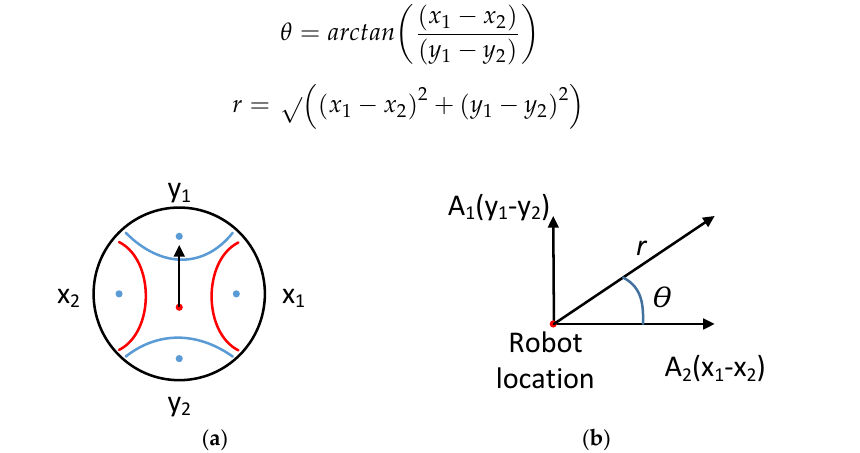
Figure 3. ( a ) Top view illustration of the physical arrangement of two pairs of antennae with their reflectors aligned along x and y axes, and ( b ) calculation of the estimated relative direction θ and distance r based on differential RSS.